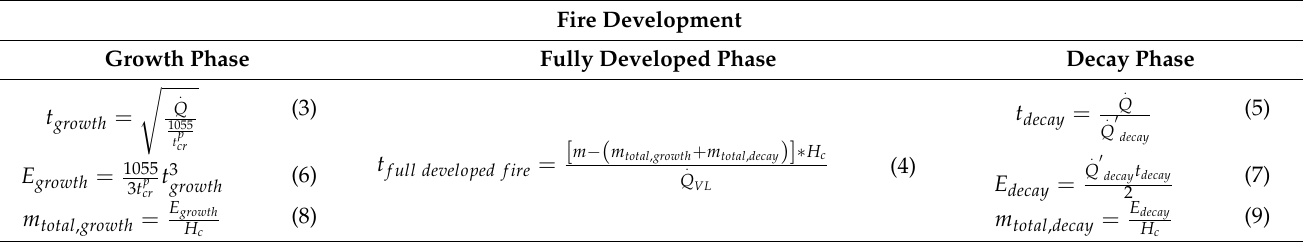
Table 2. Simplified calculations for fire development. Fire